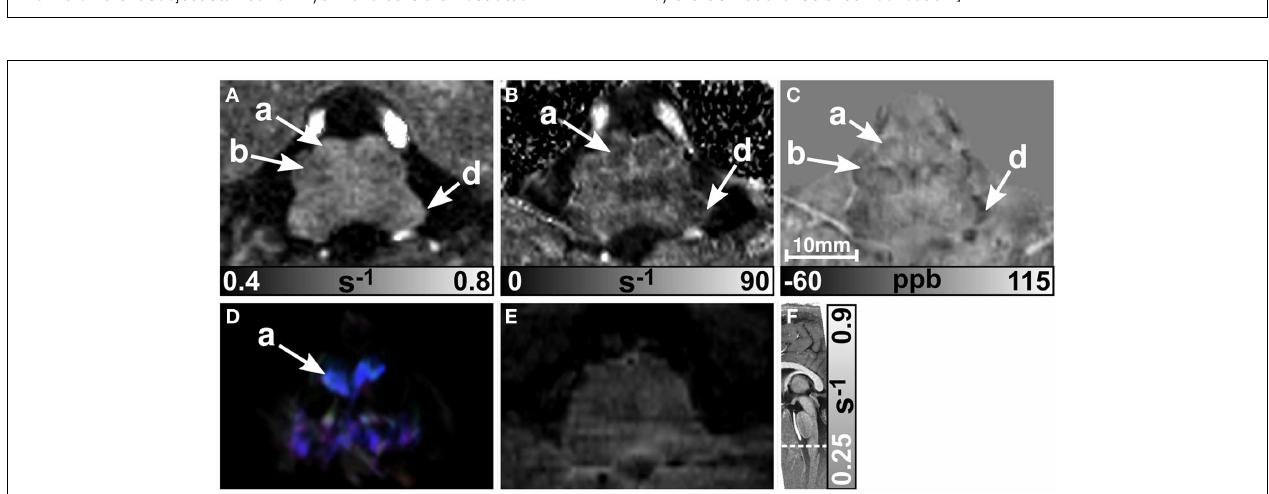
(G) and (H) , respectively.The arrows indicate: (a) pyramid, (b) inferior olive, (c) spinal trigeminal nucleus, (d) inferior cerebellar peduncle, (e) medial longitudinal fasciculus, (f) medial lemniscus, (h) reticular formation, (i) accessory cuneate nucleus, (j) solitary nucleus, (k) dorsal motor nucleus of the vagus nerve, and (l) hypoglossal nucleus. [The histological stains (G,H) were adapted with permission from http://www.brains.rad.msu.edu and http://brainmuseum.org, supported by the US National Science Foundation.]